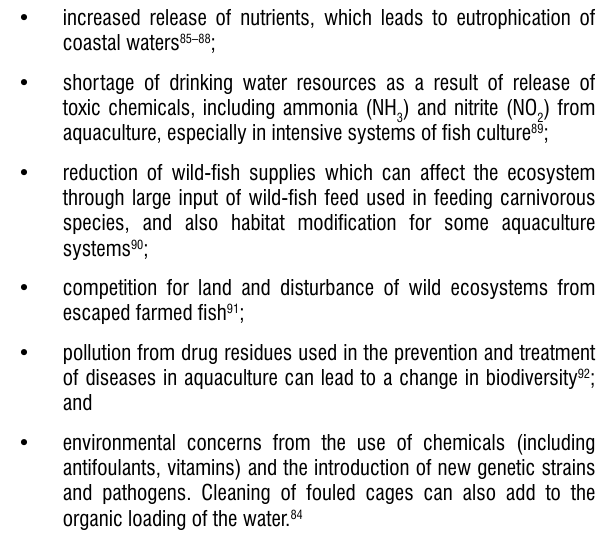
Figure 1: Nitrous oxide (N